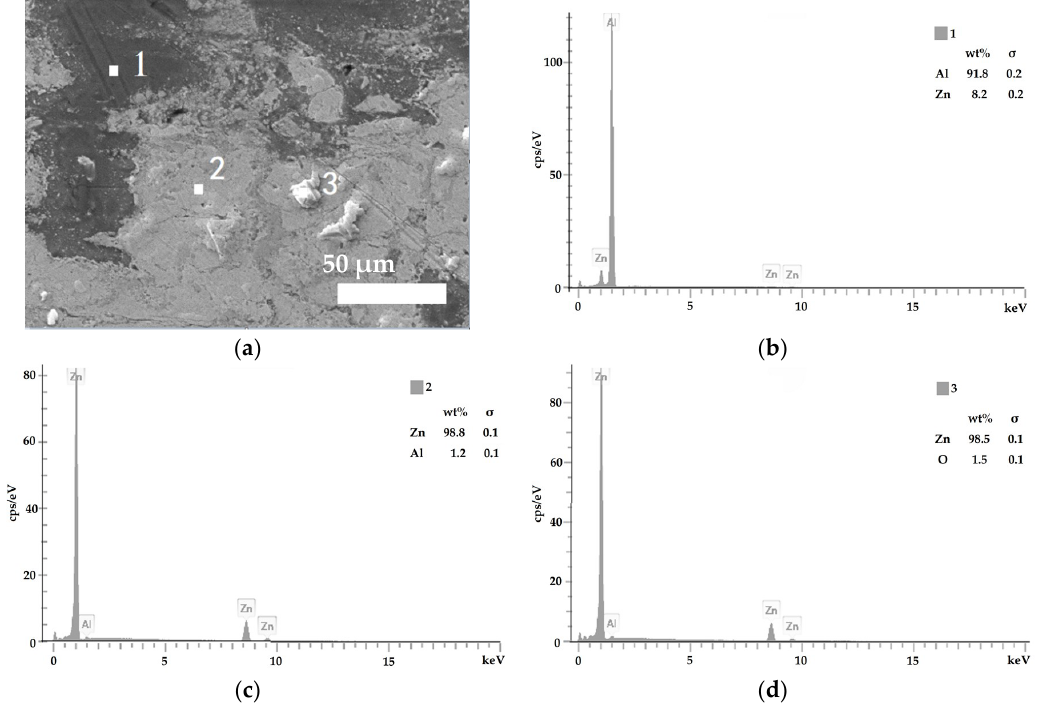
Figure 4. ( a ) Energy dispersion point spectrum (EDSP) of the Zn 45 Al 35 Mg 5 ZnO 15 composite coatings